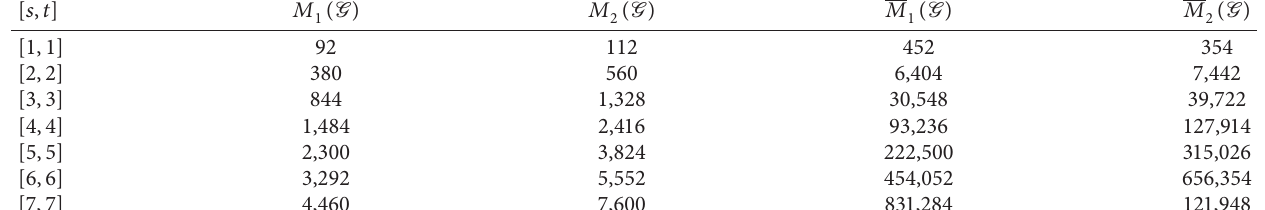
( G ) indices for InP [ s , t 2